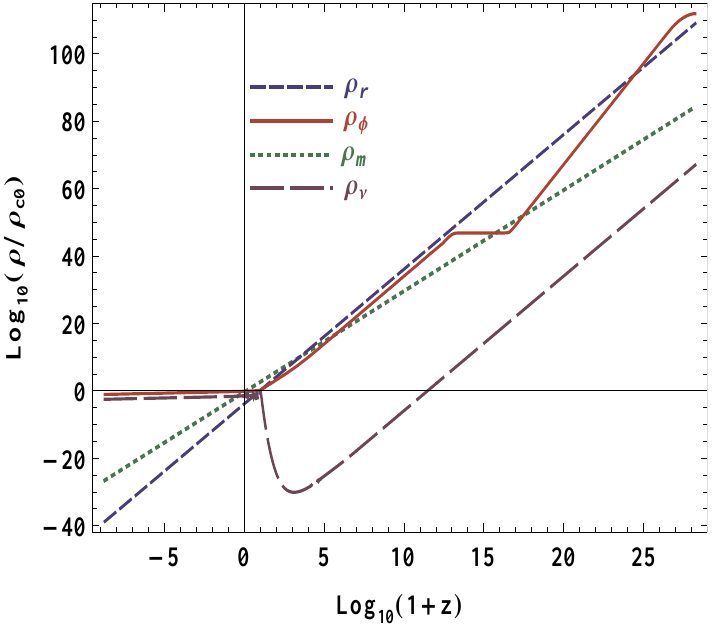
Figure 8. Plot of energy densities versus the red shift on the log scale for generalised exponential potential (69). Evolution is shown from the end of inflation. Field is shown to track the background with exit to de Sitter at late times followed by the massive neutrino matter density. Figure corresponds to numerical values of parameters: γ = 800 , λ = 10 − 8 , n = 6 z eq = 2.55 & z dur =